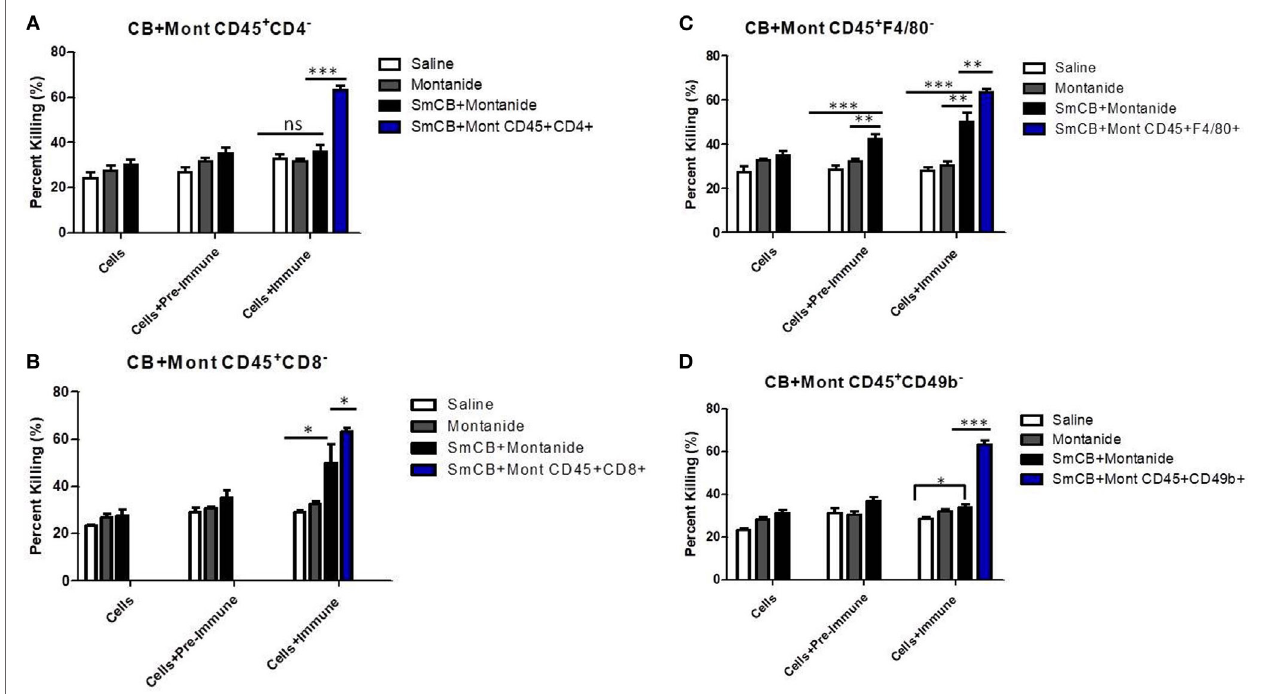
FigUre 3 | Schistosoma mansoni Cathepsin B (Sm-Cathepsin B) + Montanide: parasite killing after the depletion of different cell populations. Sixty mechanically transformed schistosomula were incubated 24 h at 37°C, 5% CO 2 under different conditions which included cells, cells + pre-immune serum, and cells + immune serum. Lung cells and serum were collected from the different immunized mouse groups: saline, Montanide ISA 720 VG, and Sm-Cathepsin B + Montanide ISA 720 VG. The different immune cell depletions were as follows: (a) parasite killing was analyzed for the control groups and the experimental group after